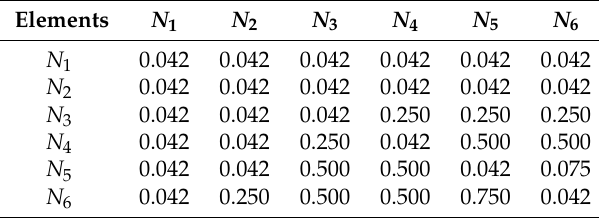
Table 3. Defuzzified direct relation matrix (DRM).